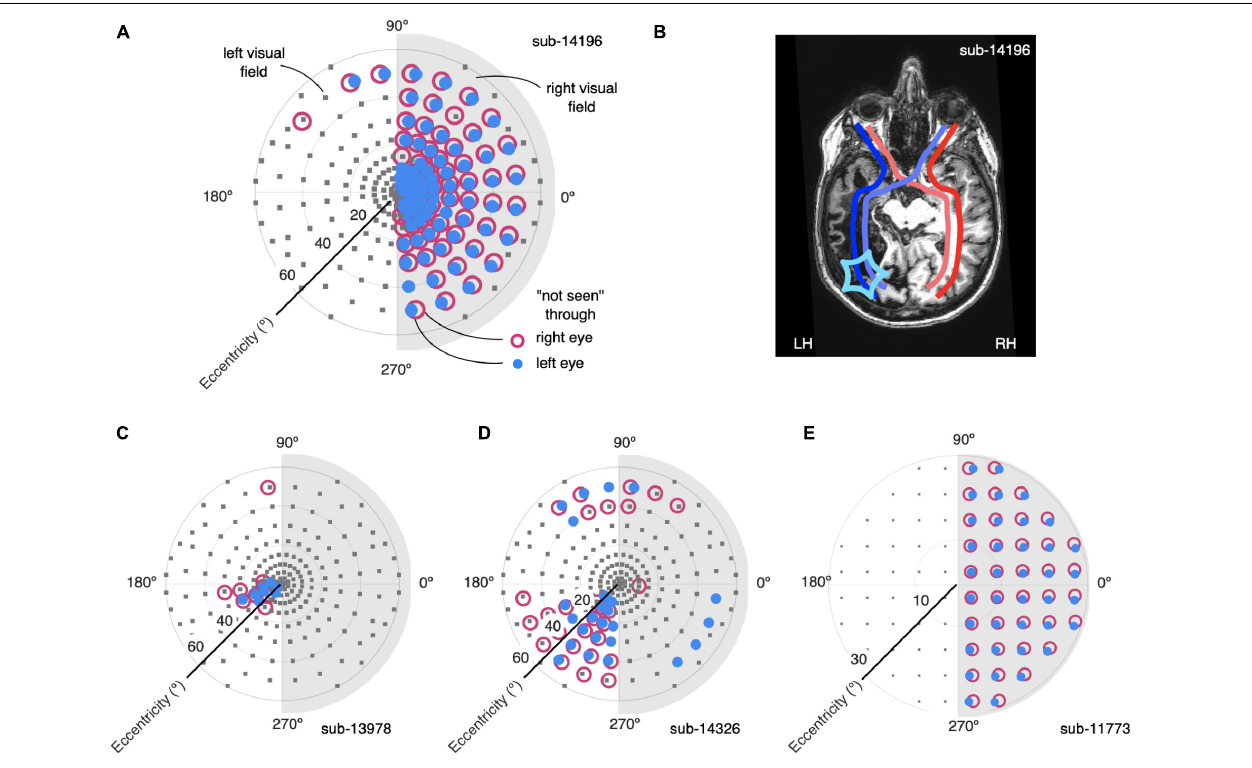
FIGURE 2 | Definition of homonymous visual field loss with perimetry and correspondence to anatomical lesions. (A) Visual field definition by standard perimetry for participant 14196. Test locations (gray squares) were equally spaced across the left and right portion (light gray shading) visual field. Locations at which the participant did not respond to stimuli are shown for both monocular tests [red open symbols, tested through right eye (OD), close blue symbols, tested through left eye (OS)]. There is a tight correspondence between the two sets of measurements, indicating a homonymous visual field defect. (B) Annotated slice of anatomical MRI scan for participant 14196. Dark blue, red lines show projections from the temporal retinae. Light blue, red lines show projections from the nasal retinae. The extent and location of the cortical lesion (star symbol in left hemisphere, LH) determines the contralateral visual field loss. There was no apparent cortical loss in the right hemisphere, RH, reflecting the perimetry measurements in (A) . (C–E) Perimetry results for the other participants in our study in the same convention as (A) . Note that for participant 11773 perimetry was performed with slightly different parameters and only extended to 30 ◦ eccentricity.